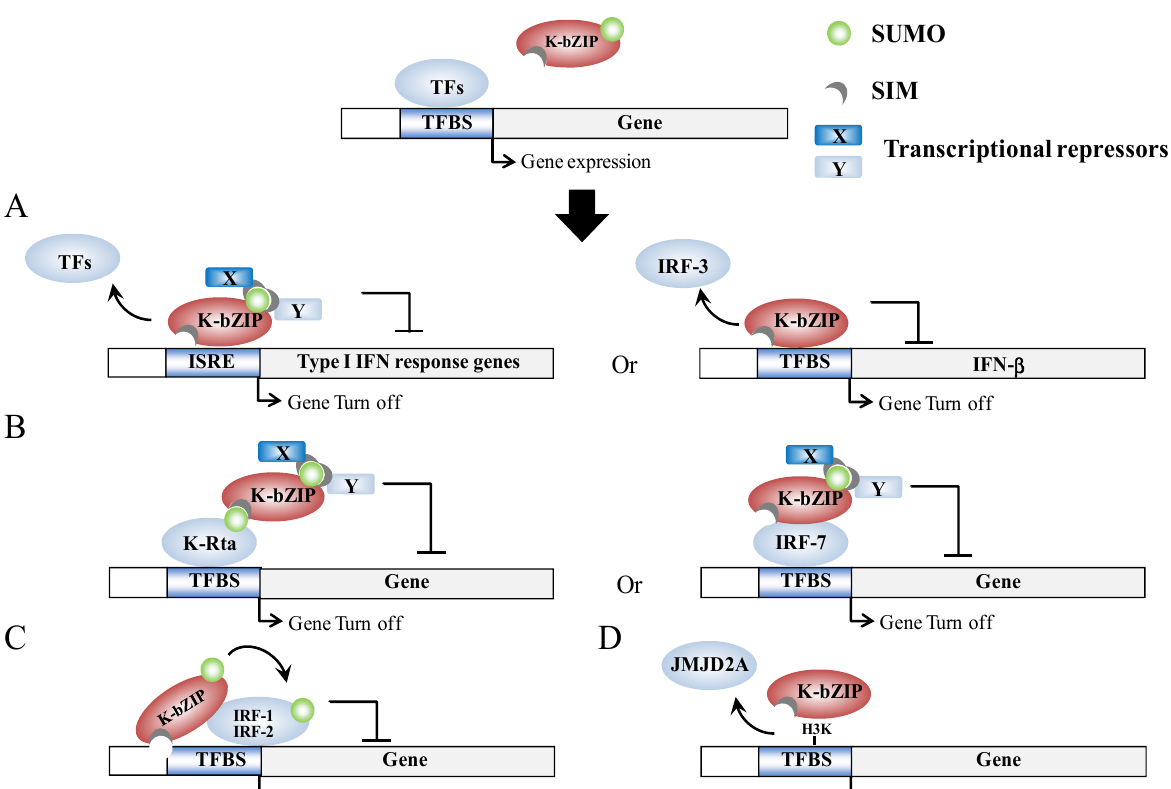
Figure 3. Model outlining epigenetic regulation by K-bZIP. ( A ) K-bZIP is able to directly compete for TFBS binding with TFs in the promoter of target genes in a sumoylation-dependent (left) or in a sumoylation-independent (right) manner; ( B ) K-bZIP is able to interact with TFs in a SUMO-dependent (left) or in a SUMO-independent (right) manner, which in turn inhibits gene expression via sumoylation-dependent recruitment of transcriptional repressors; ( C ) Sumoylation of TFs by K-bZIP in a SIM-dependent manner; ( D ) K-bZIP is able to directly interact with and compete with histone modification enzyme activity in SUMO-independent